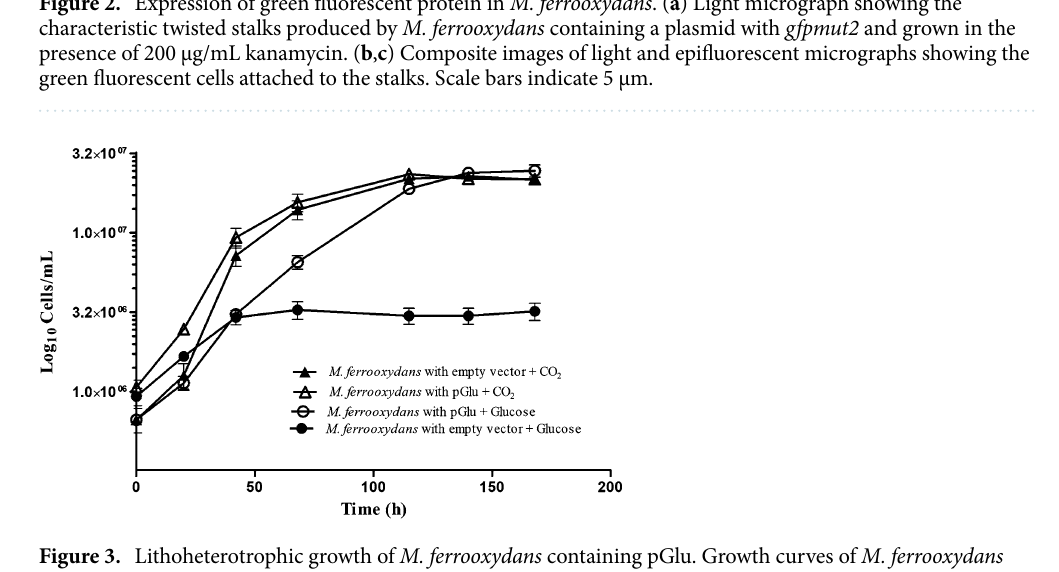
Figure 3. Lithoheterotrophic growth of M. ferrooxydans containing pGlu. Growth curves of M. ferrooxydans containing pGlu (open symbols) and M. ferrooxydans containing empty vector pRK2m3 (closed symbols) grown on either glucose (o, ) or carbon dioxide (∆, ▲ ) as the sole carbon source. Error bars represent standard deviation of three ●